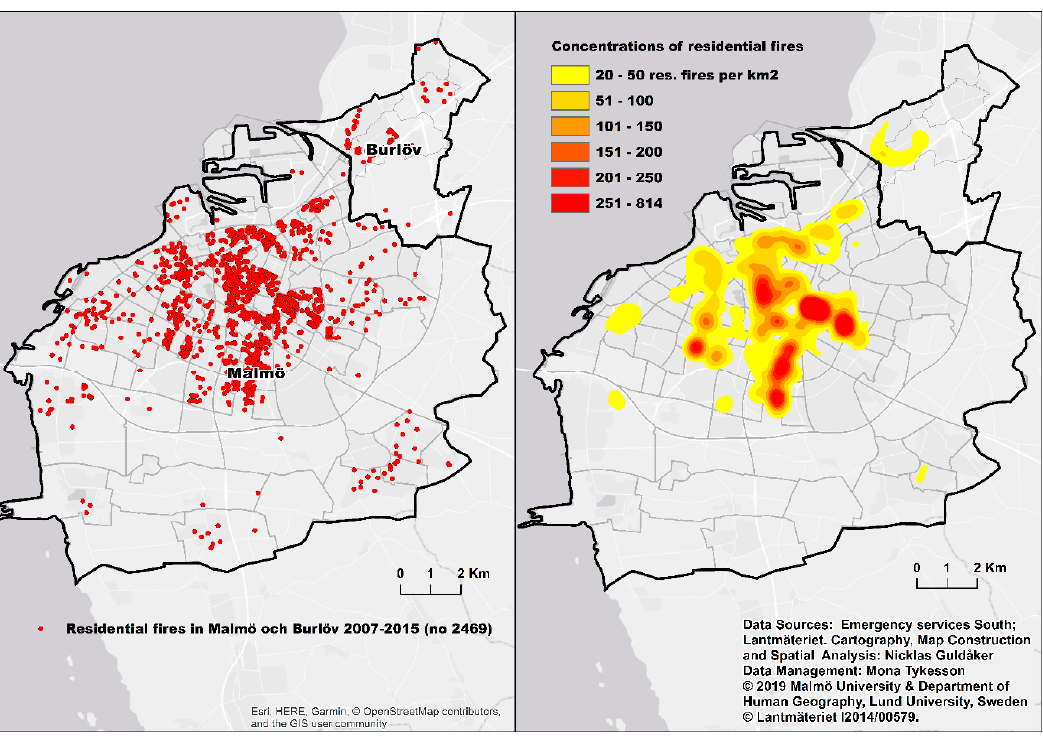
Figure 4. Point map ( left ) and heat map ( right ) of the municipalities of Malmö and Burlöv, Sweden. The residential fire data period is 2007–2015.